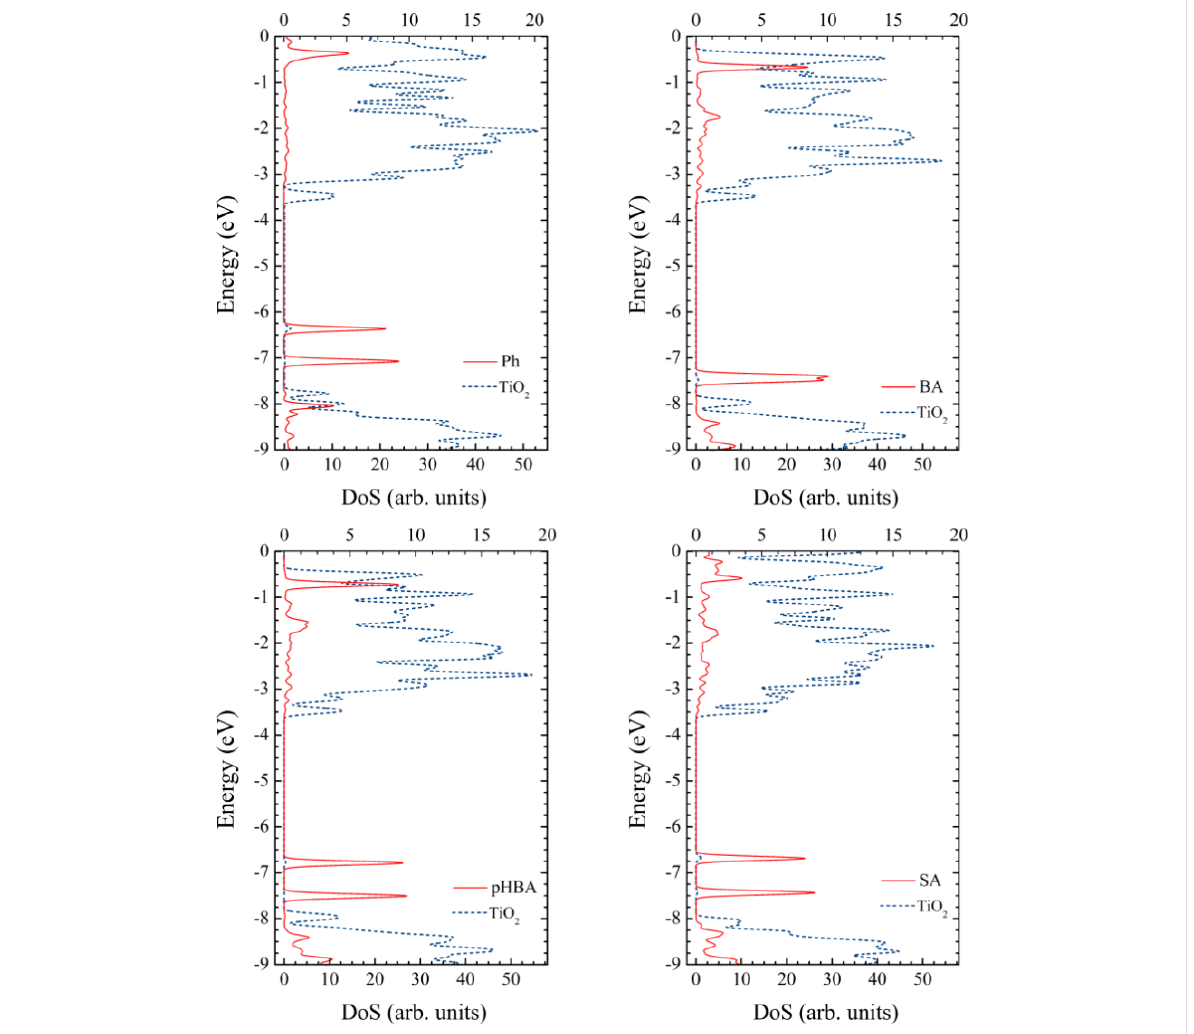
Figure 9: Density of states of the pollutant–catalyst complex systems, calculated at the DFT/B3LYP/DZVP level in water. Bottom scale is for the contribution of the Ti 24 O 50 H 4 nanocluster (dotted line) whereas the top scale for the contribution of the pollutant (continues line). For all systems, the edge of the p-type valence band of the semiconductor is located at about − 7.9 eV, whereas the d-type conduction band edge is situated at about − 3.7 eV. The HOMOs of the pollutant are located in the gap of the